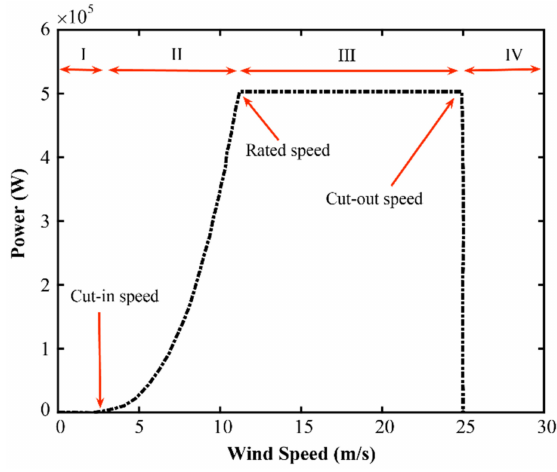
Figure 4. Wind power curve vs. wind